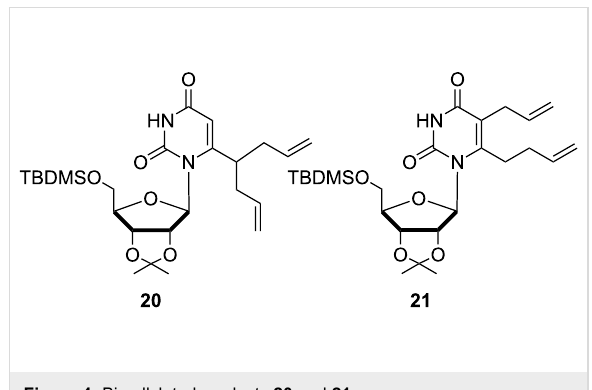
Figure 4: Bis-allylated products 20 and 21